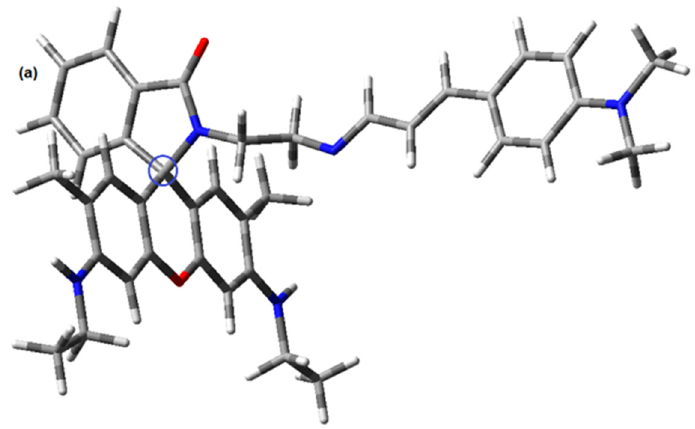
Figure 2. ( a ) Absorbance spectra of RLED (10 μ M) in MeOH/HEPES (pH 7.4; 1/9; v / v ) at 25 °C upon the addition of 1 equivalent of Hg 2+ and other metal ions, including Cu 2+ , Zn 2+ , Pb 2+ , Cd 2+ , Fe 2+ , Co 2+